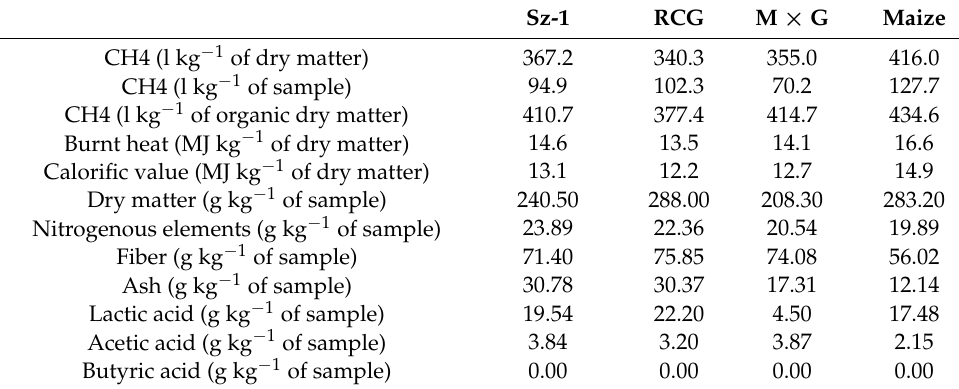
Table 15. Results of assessment of silage